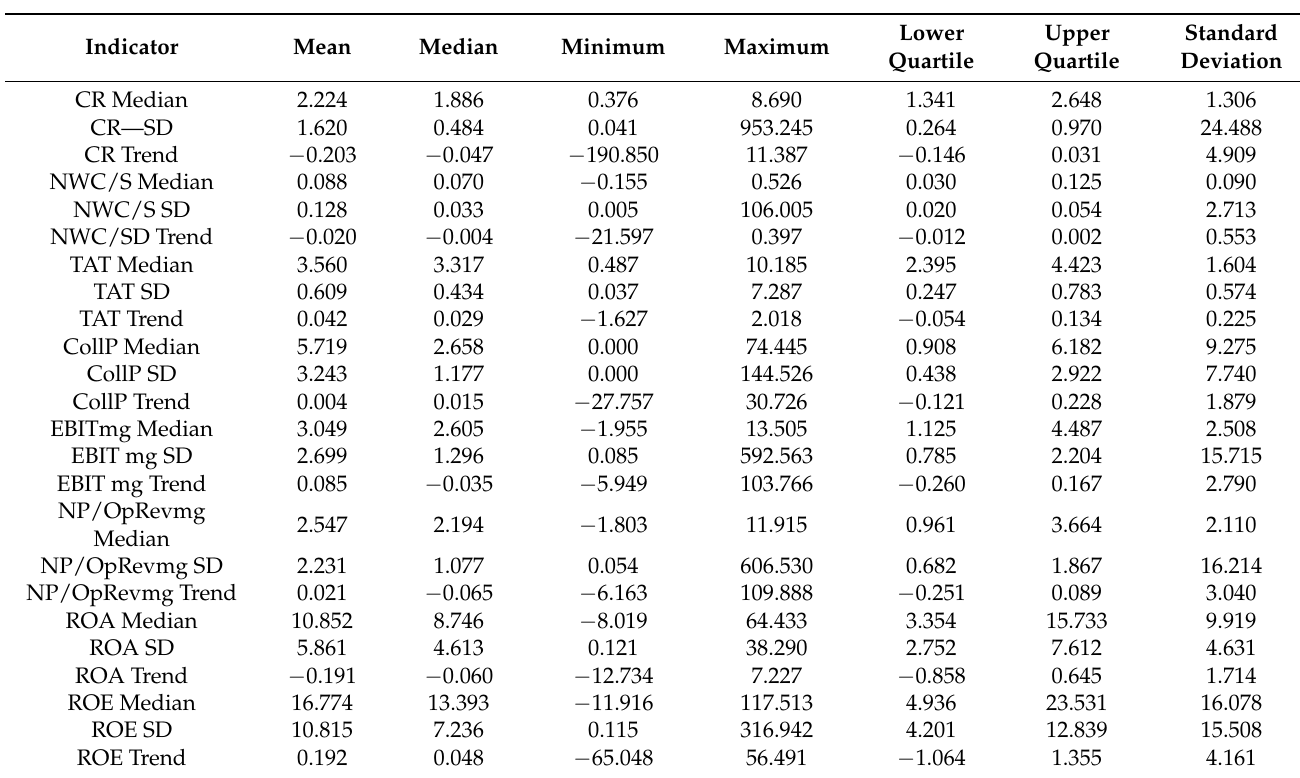
Table A5. Descriptive statistics of liquidity, efficiency, profitability, and aggregate performance indicators for low solvency risk companies,